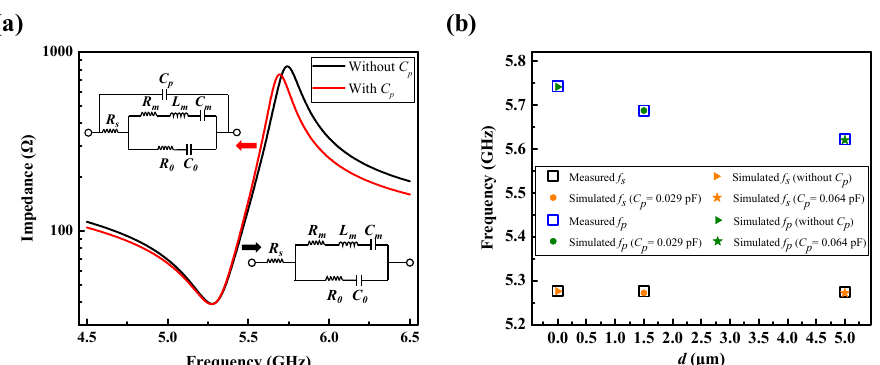
Figure 6. ( a ) Comparison of impedance curves with and without an external capacitor connected in parallel with a resonator. ( b ) Measured frequencies of resonators with different distance ( d ) are fitted by capacitors ( C p ).